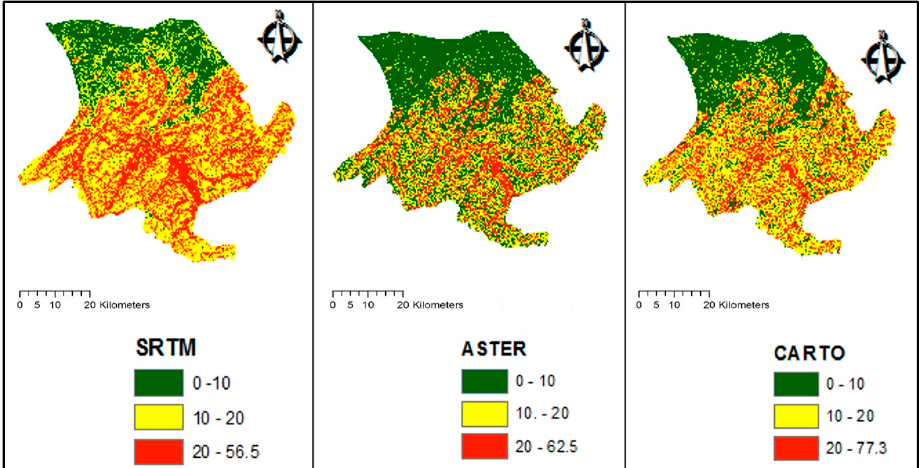
Figure 5. DEM-derived slopes in the study.